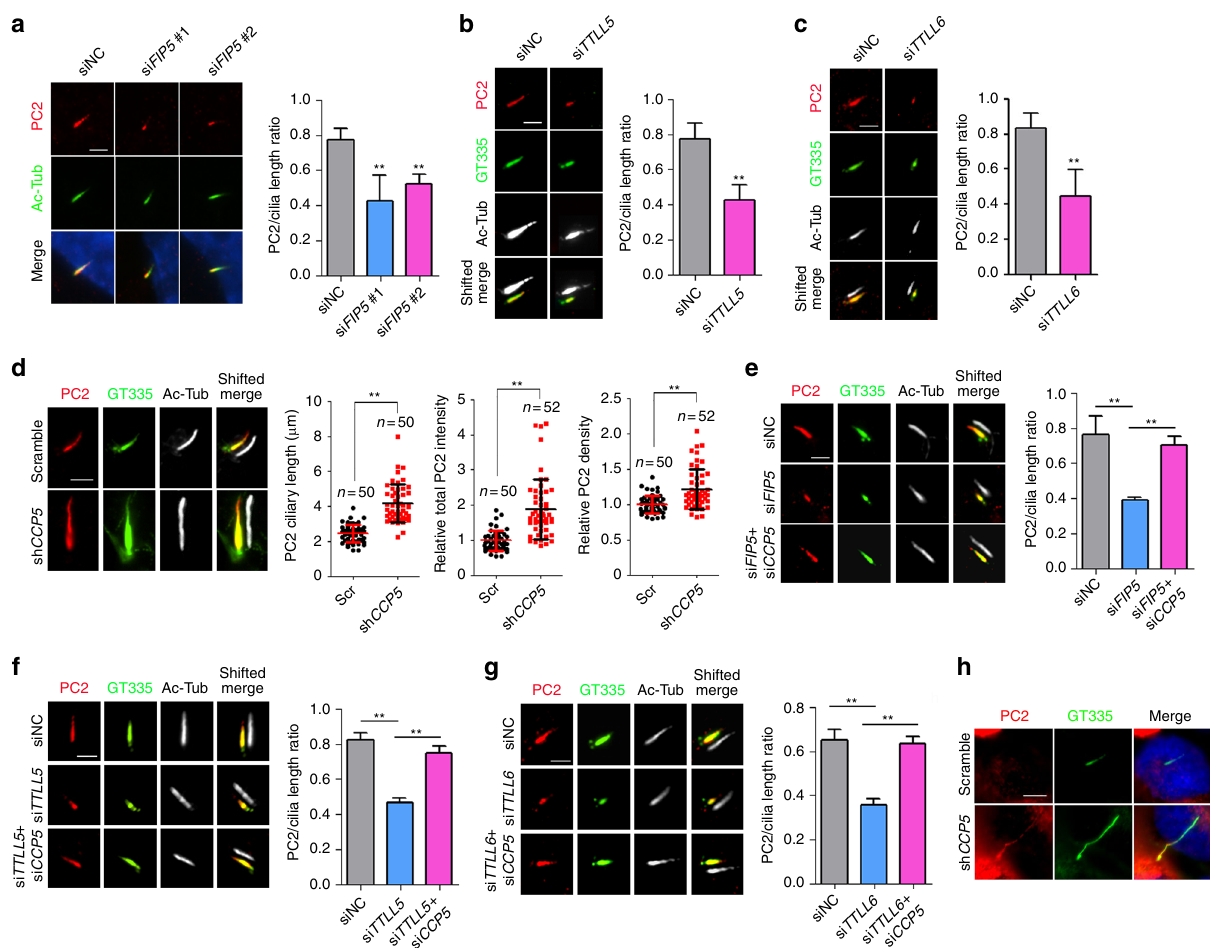
Fig. 6 Axoneme hypoglutamylation compromises the ciliary localization of polycystins, which can be restored by concomitant depletion of deglutamylase CCP5. a – c hTERT-RPE-1 cells were treated with indicated siRNAs for 48 h and serum starved for 24 h. Ciliary localizations of endogenous Polycystin 2 (PC2) were examined by immuno fl uorescence staining. The (PC2 staining)/(cilia length) ratios were quanti fi ed in the right panel ( n = 50 cilia for each group). d CCP5 -depleted stable hTERT-RPE-1 cells were constructed by shRNA lentivirus system. Scramble shRNA sequence was used as negative control. Ciliary localization of PC2 was examined by immuno fl uorescence staining. The length, total intensity and relative intensity/ μ m 2 of ciliary PC2 were quanti fi ed in the right panels. e – g Depletion of CCP5 restored the ciliary localizations of PC2 in FIP5 - ( e ), TTLL5- ( f ), or TTLL6 - ( g ) depleted hTERT-RPE-1 cells. Cells were treated with indicated siRNAs and the (PC2 staining)/(cilia length) ratios were quanti fi ed in the right panels ( n = 40 cilia for each group). h CCP5 -depleted stable GANAB − / − RCTE cells were constructed by shRNA lentivirus system. Ciliary localizations of PC2 were examined by immuno fl uorescence staining. Scale bars in a – g are 2 μ m. Scale bar in h is 5 μ m. Center values represent mean. Error bars represent s.d. N values: cilia number accessed from at least six fi elds. Statistical signi fi cance was determined using unpaired Student ’ s t test. ** p < PKD2 localization, comparable to that of WT cells (Fig. 6e – g). Of of signaling molecules such as GLI3. Unlike polycystins, cilia hypoglutamylation shows no effect on the ciliary localization of either endogenous Smoothened (SMO) receptor or overexpressed SMO-M2 mutants (Supplementary Fig. 7a, b). In hyperglutamy- lated cilia induced by CCP5 depletion, SMO signal in cilia are longer but shows normal average intensity (Supplementary Fig. 7c, d), indicating the speci fi city of axoneme polyglutamyla- tion in controlling ciliary localization of signaling molecules in different pathways. Interestingly, in FIP5 -knockdown RPE cells, GLI3 failed to translocate to cilia tip upon Shh activation (Fig. 7a). Consequently, the expression of GLI1 , the downstream reporter of Shh signaling, was also suppressed in FIP5 or TTLL - depleted cells (Fig. 7b). Interestingly, CCP5 -depleted cilia show slightly decreased GLI3 tip localization which may due to the increased cilia length (Fig. 7c). Nevertheless, CCP5 knockdown restored the ciliary tip translocation of GLI3 as well as the expression of downstream Shh reporter GLI1 upon SAG treat- ment in FIP5 or TTLL5 -depleted cells (Fig. 7d, e). These data